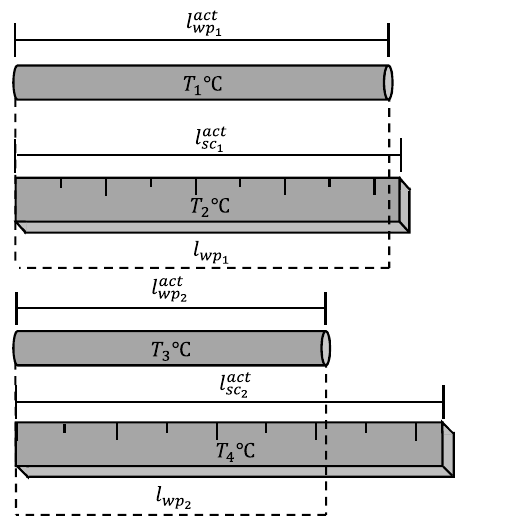
Figure 4. Behavior of both objects at different